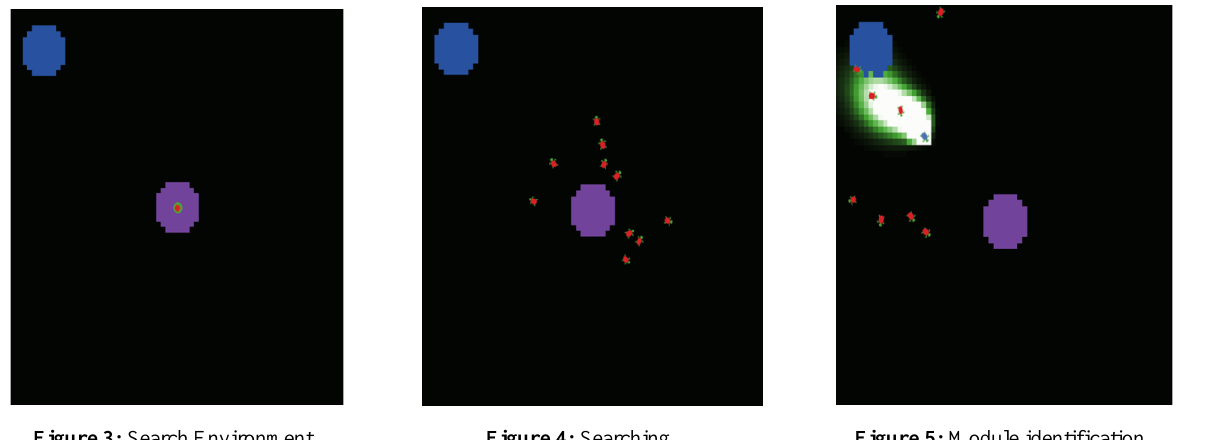
Figure 3: Search Environment. Figure 4: Searching Figure 5: Module identification